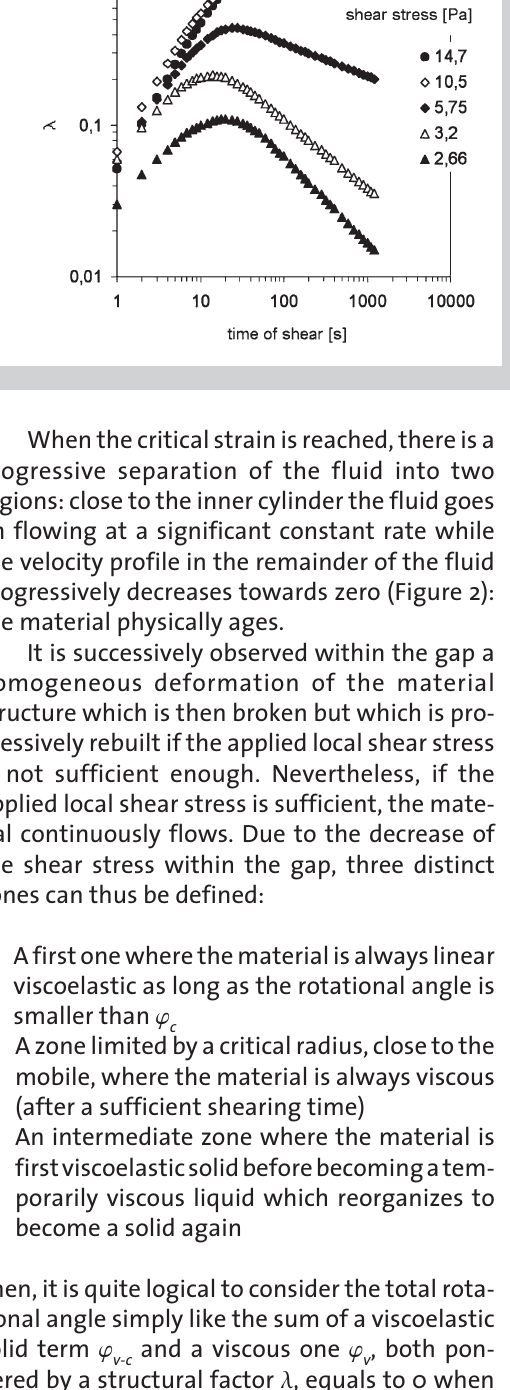
Figure 3 (left): Evolution of the structural parameter depending the applied shear stress for a sludge at 6% DM (dry mat- ter). Figure 4: Evolution of the apparent rheological behaviour of the same pasty sludge (15% DM) in relationship with the shear duration of each step. To obtain one point, the sludge is sheared during 1 minute (triangle) or 20 minutes